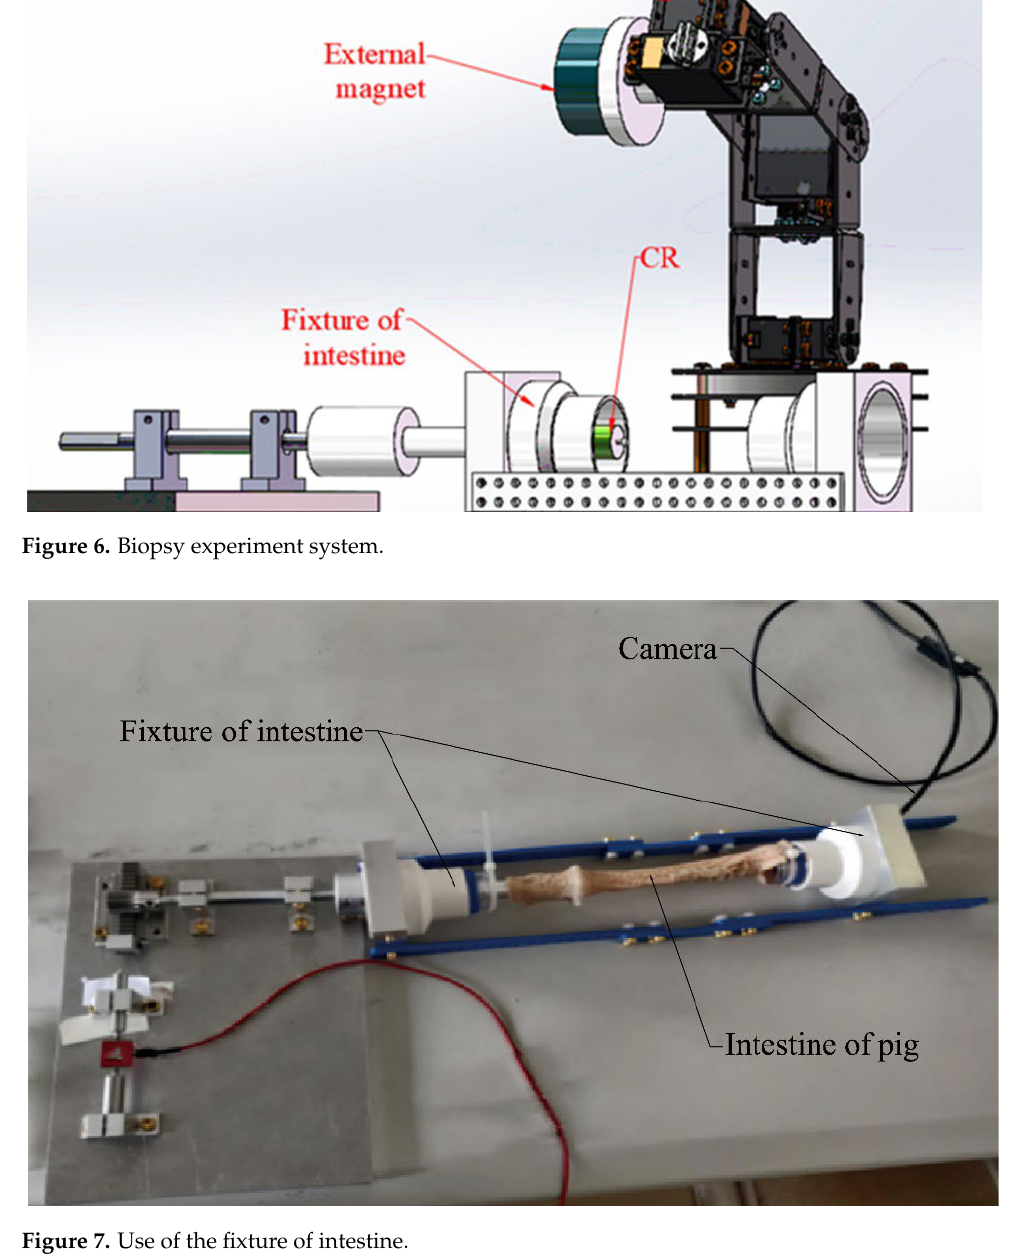
Figure 7. Use of the fixture of intestine.